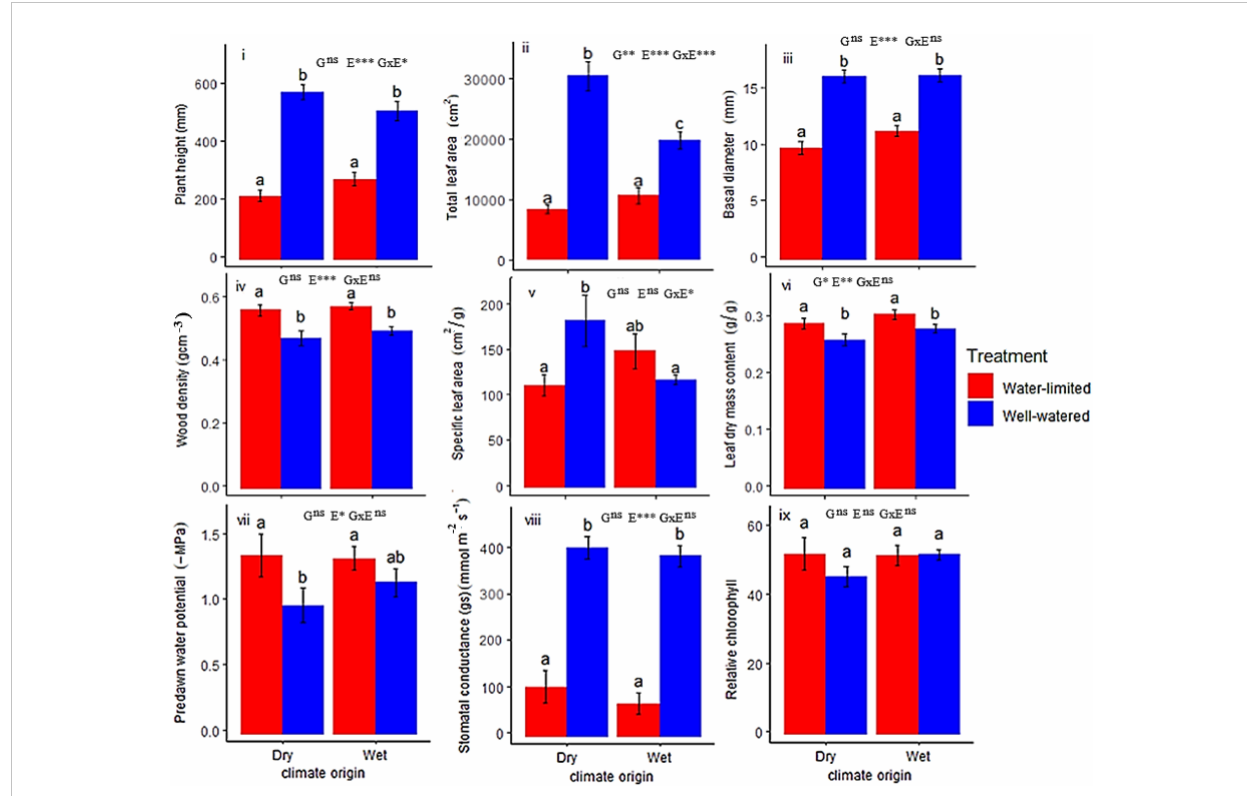
FIGURE 1 Trait expressions of wet and dry climate-origin populations under water-limited (WL) and well-watered (WW) treatments. G means genotype differences (or climate-origin differences), while E means environment (treatment differences). G x E means interaction between G and E i.e., genotype-by-environment. Signi fi cant codes: 0 ‘ *** ’ 0.001 ‘ ** ’ 0.01 ‘ * ’ 0.05 ns not-sigi fi cant. The results of the Tukey posthoc test are shown with letters above the bars. Different letters are signi fi cantly different, while the same letter is statistically